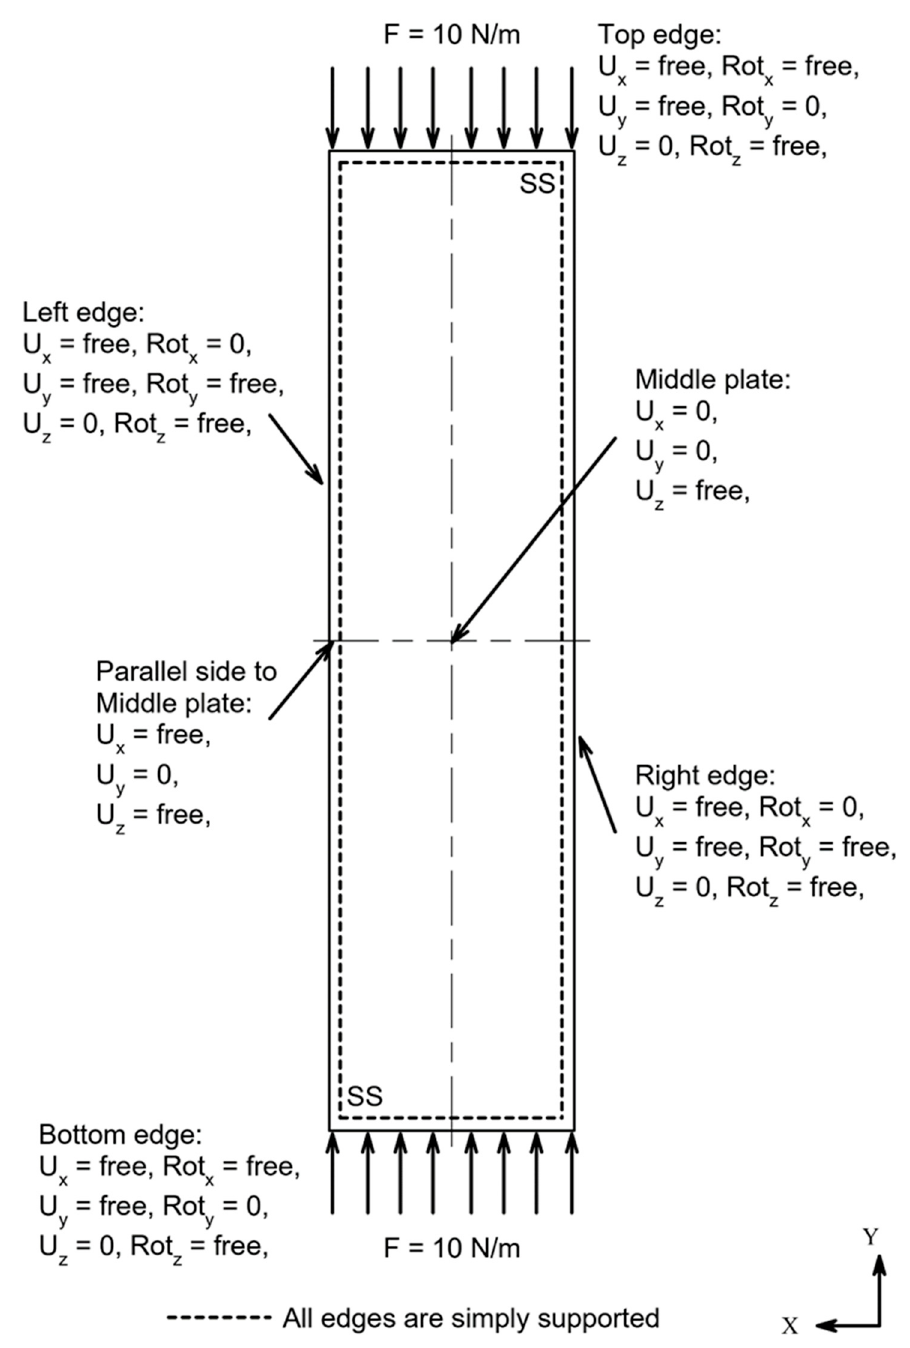
Figure 13. Linear boundary condition of the simply supported rectangular plate.